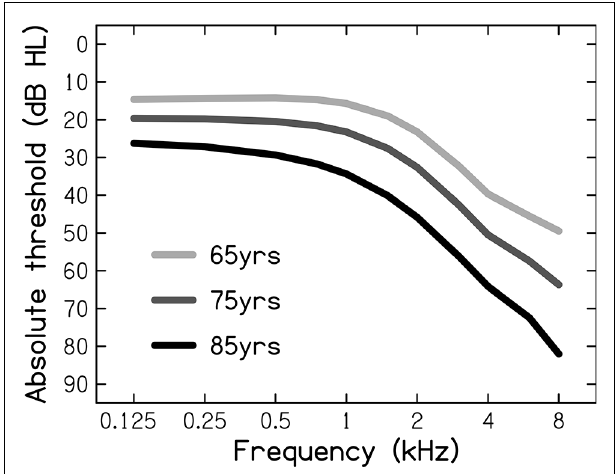
FIGURE 1 | Audiometric thresholds (in dB Hearing Level, dB HL) for the average person aged 65, 75, and 85 years, used as the input for the hearing-loss